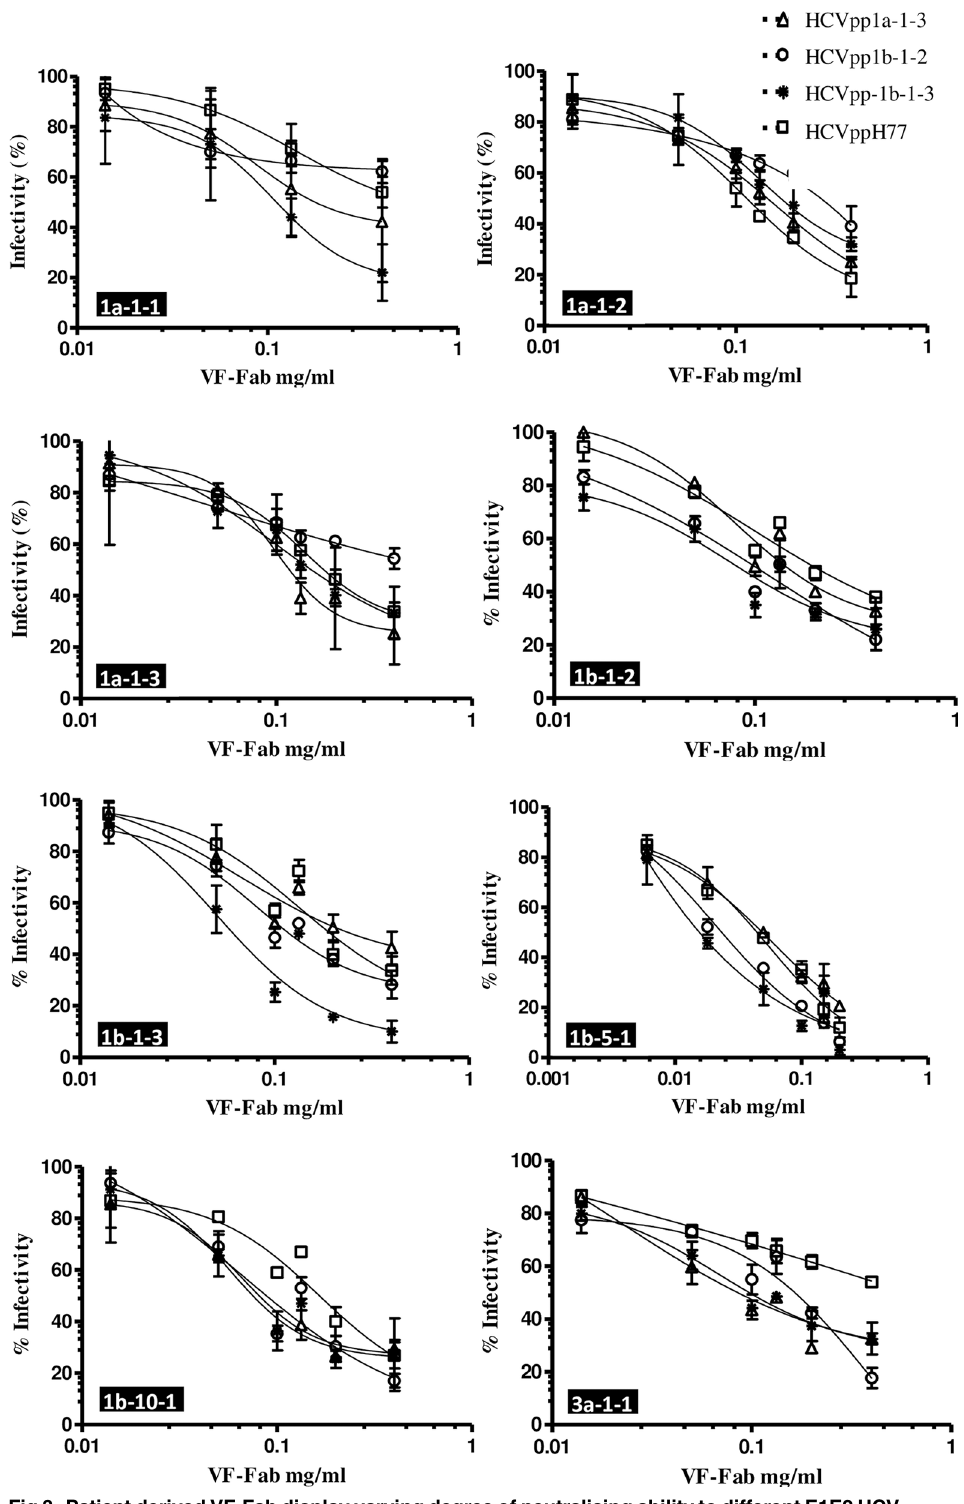
Fig 3. Patient derived VF-Fab display varying degree of neutralising ability to different E1E2 HCV pseudoparticles. VF-Fab were purifiedfrom antibody-virus complex. VF-Fab1a-1-1, VF-Fab1a-1-2, VF-Fab 1a-1-3 were purifiedfrom a patient infected with HCV genotype1a. VF-Fab1b-1-2, VF-Fab1b-1-3 and VF- Fab1b-10-1 were purifiedfrom a patients infected with genotype1b whose common source of infection